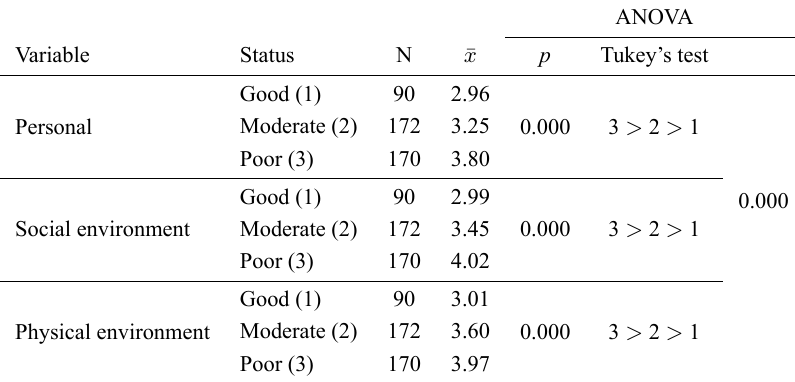
Table 5. ANOVA test results for subdimensions of barriers to physical activity, by self-perceived health status of the participants during the COVID-19 lockdown period.